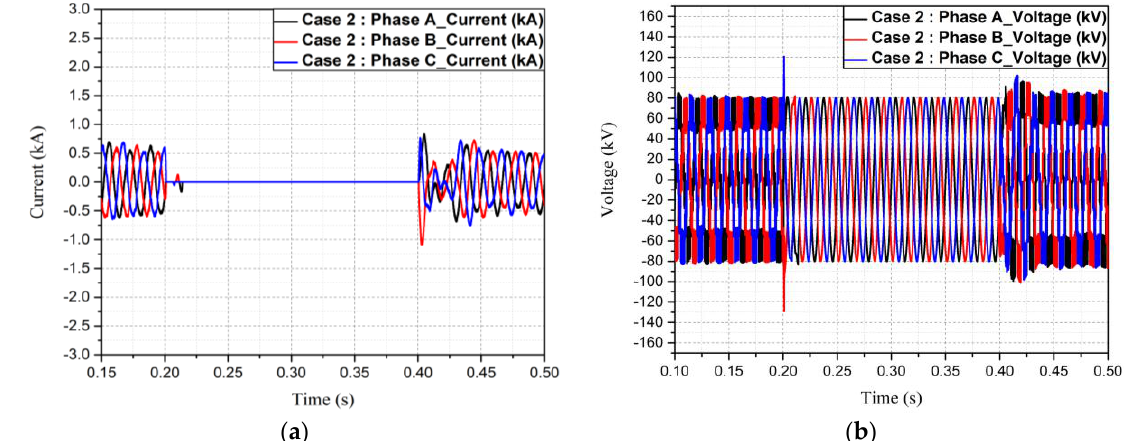
Figure 12. The current and voltage waveform at the AC side of Case-2 in interruption and reclosing operations: ( a ) current waveform; ( b ) voltage waveform.